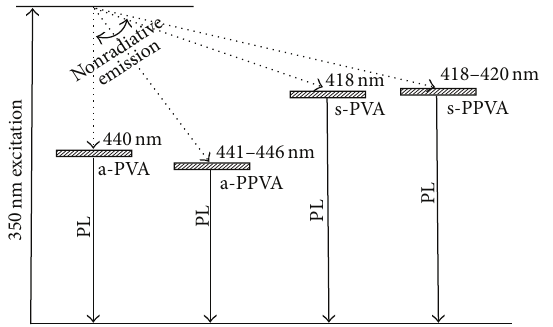
Figure 9: Energy level diagram which shows PL emissions and nonradiative processes occurring simultaneously in a-PVA and s- PPVA polymer molecules at resonance excitation of 350 nm.